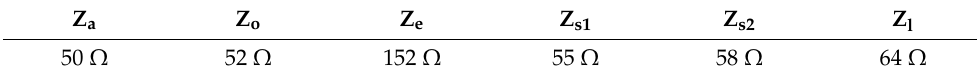
Table 6. Impedance values of the 10 GHz filter different elements.